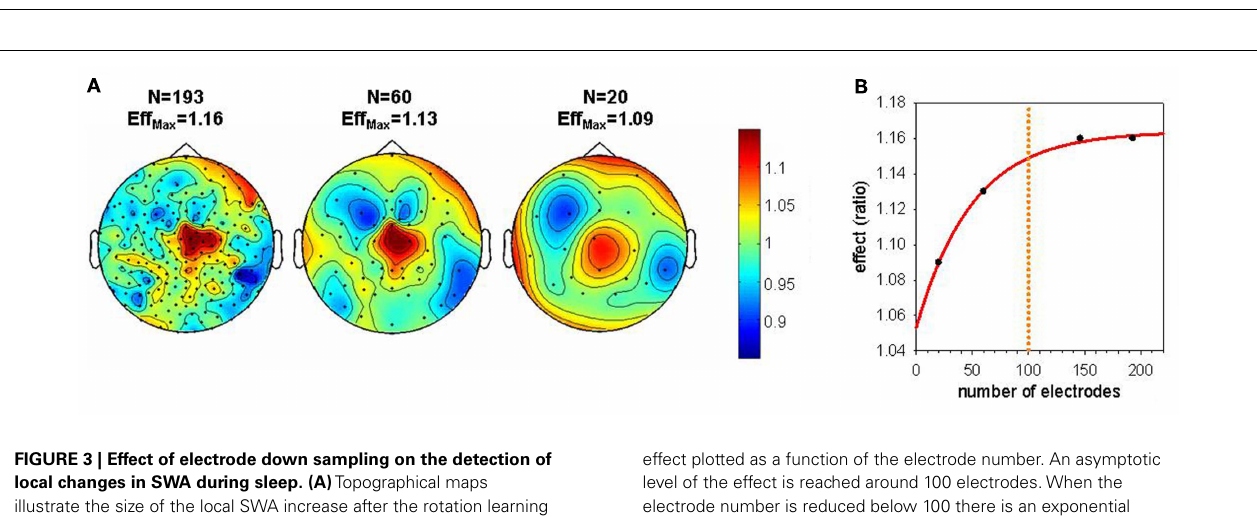
FIGURE 2 |Topographical distribution of slow wave activity (EEG power between 0.75 and 4.5Hz) during the first hour of NREM sleep for individuals within defined age-groups. Black dots represent all 109 EEG electrodes included in this analysis.Values are color coded (red: maxima, blue: minima). Numbers plotted on the right side of each map depict the maximal (red) and minimal (blue) value within each map. Topographical maps are proportionally scaled and missing electrode values were interpolated. Representative subjects up to 24years were